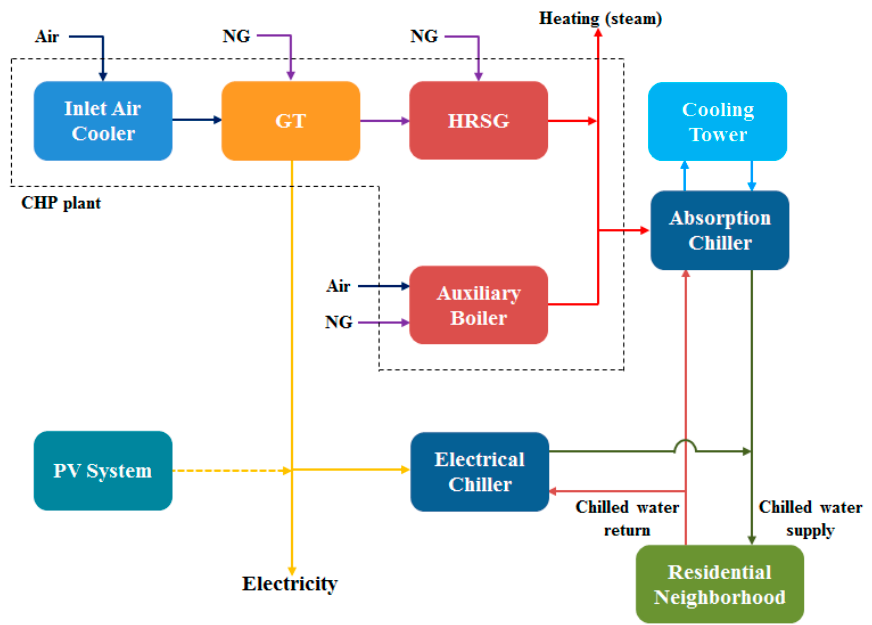
Figure 3. NG- and solar PV-powered tri-generation system proposed by Ondeck et al. for future residential neighborhoods in hot-climate regions, adapted from [28]. Note: CHP—combined heat and power; GT—gas turbine; HRSG—heat recovery steam generator; NG—natural gas; PV—photovoltaic.